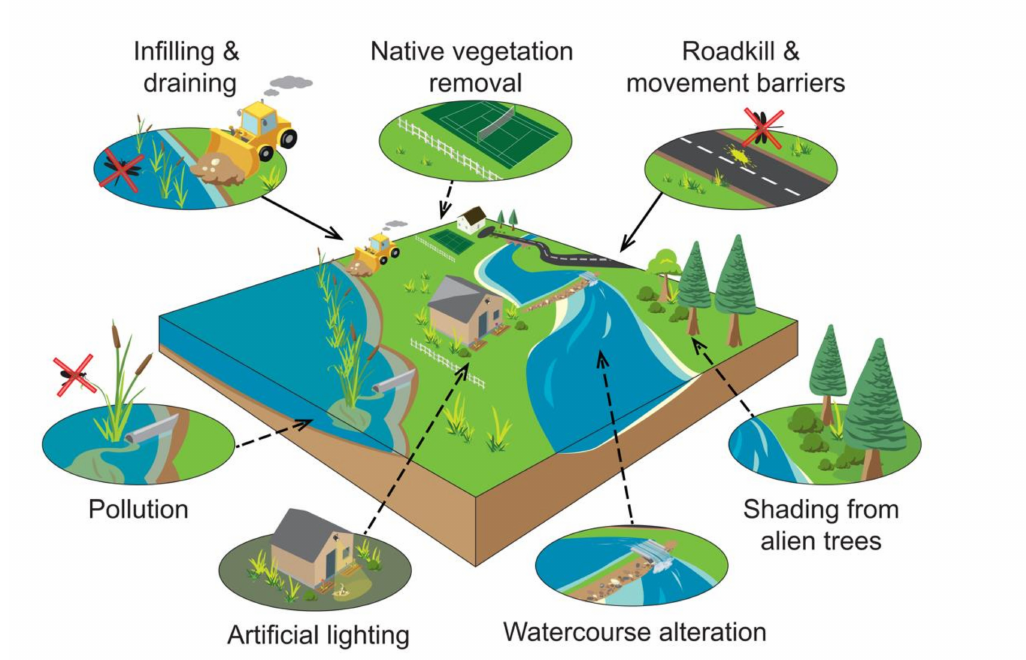
Figure 1. Direct (solid arrows) and indirect (dashed arrows) impacts of urbanization on dragonflies. These impact act synergistically, and together exert immense pressure on dragonflies in urban areas. Red crosses indicate elimination of